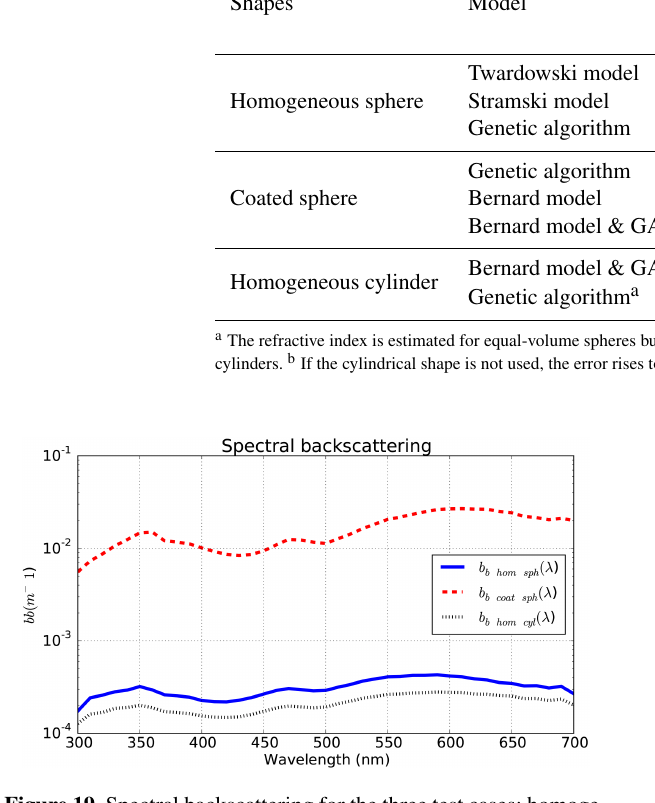
Figure 19. Spectral backscattering for the three test cases: homoge- neous sphere, coated sphere, and homogeneous